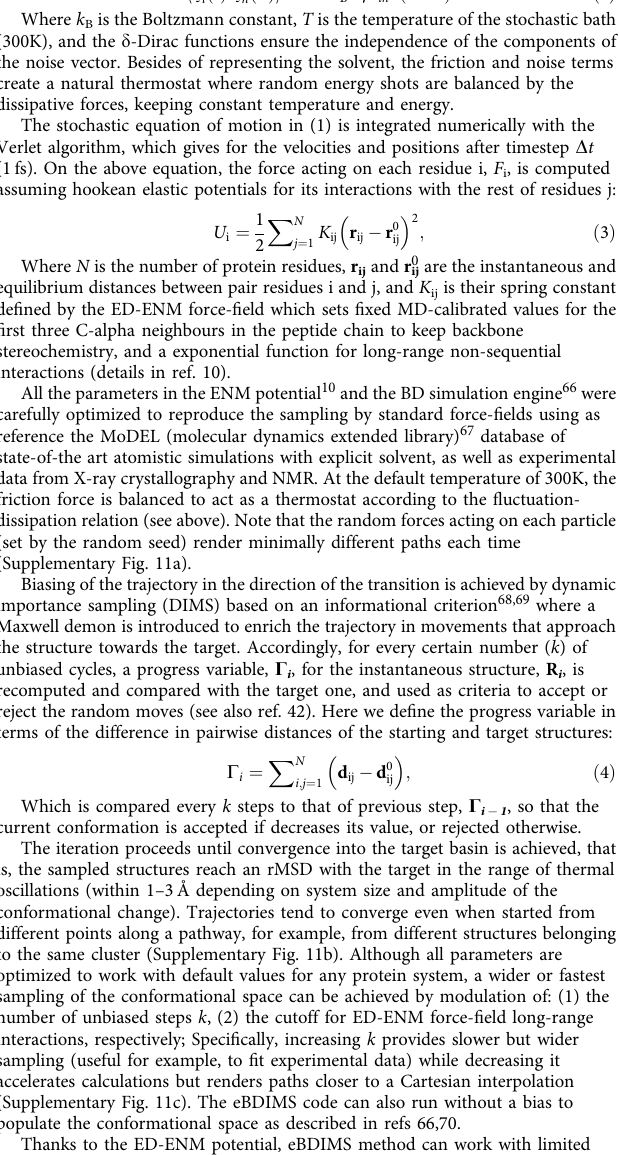
(Supplementary Table 1): (i) knowledge-based (that is, heuristic) intermediates, which are already characterized as such and have been trapped by specifically designed mutations and so on; (ii) topology-based intermediates, which appear as natural conformers along the routes connecting end-states in the PC1-2 subspace, and correspond to structures bound to inhibitors or harbouring mutations that have accidentally trapped a transient